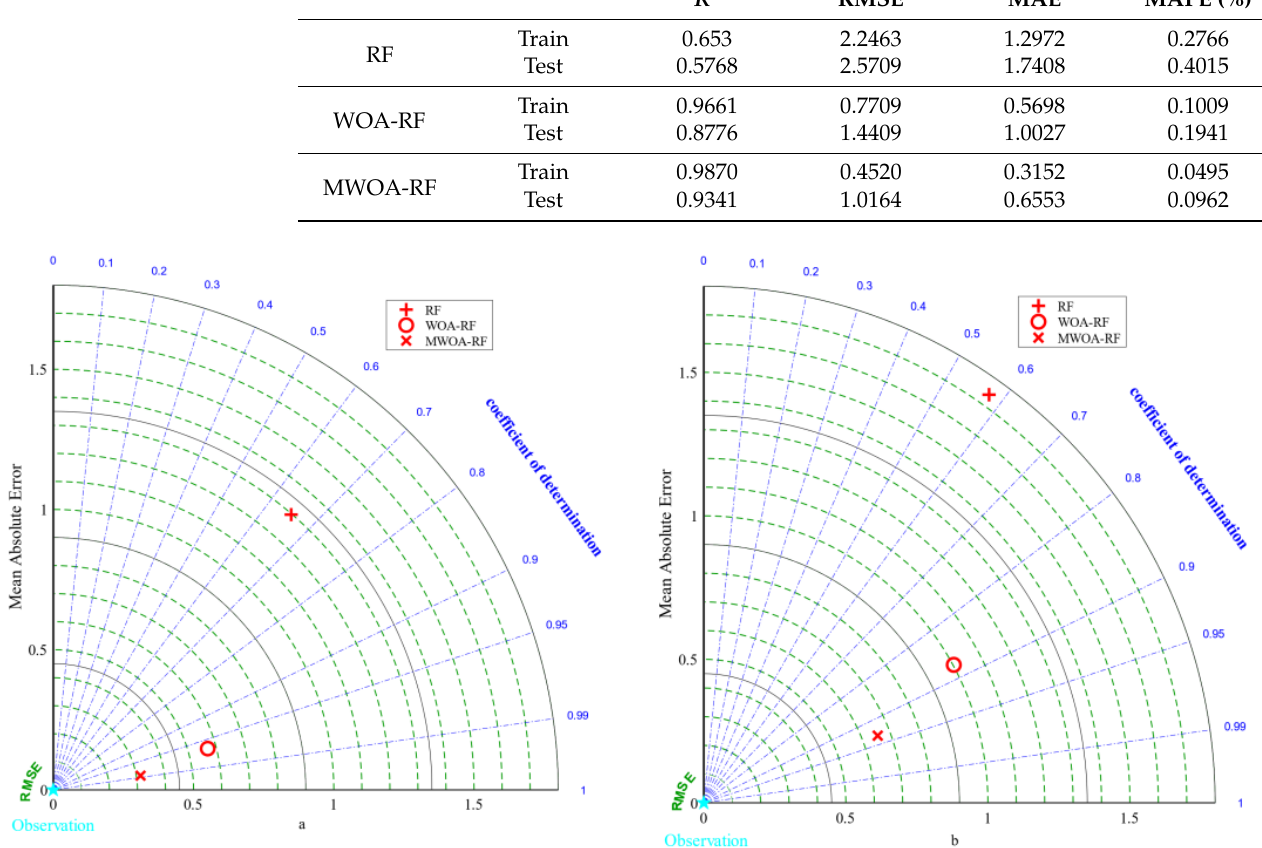
Table 6. Parameter settings for the MWOA-ELMAN